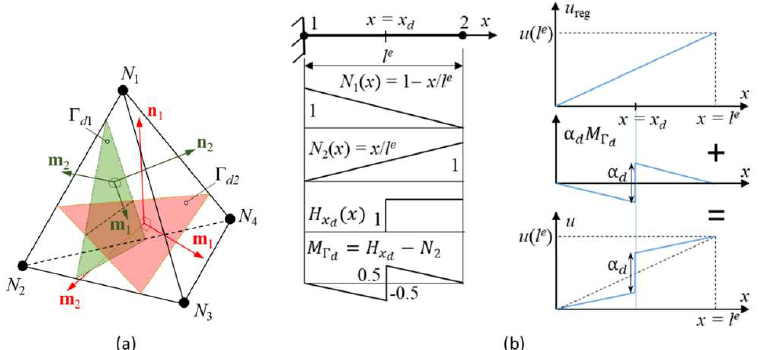
Figure 1. ( a ) Linear tetrahedron element with two intersecting discontinuity planes ( n 1 , m 1 , m 2 : normal and tangent vectors for cracks 1 ( Γ d 1 ) and 2 ( Γ d 2 ; N i : interpolation function at node i ); ( b ) Illustration of the displacement decomposition to regular and enhanced part and the corresponding functions in 1D case ( u reg : regular displacement; u : total displacement; α d ; displacement jump; M Γ : special function restricting the effect of α d inside the